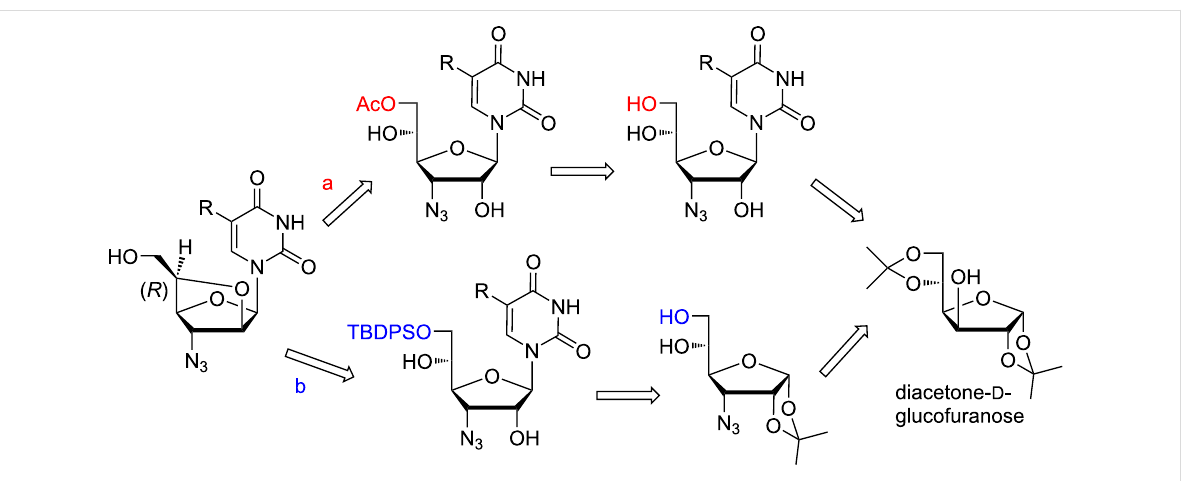
Scheme 1: Retrosynthetic routes for the synthesis of (5 ′ R )-3 ′ -azido-3 ′ -deoxy-2 ′ - O ,5 ′ - C -bridged- β - ᴅ -homoarabinofuranosylpyrimidines following a chemoenzymatic pathway (a) and a chemical pathway